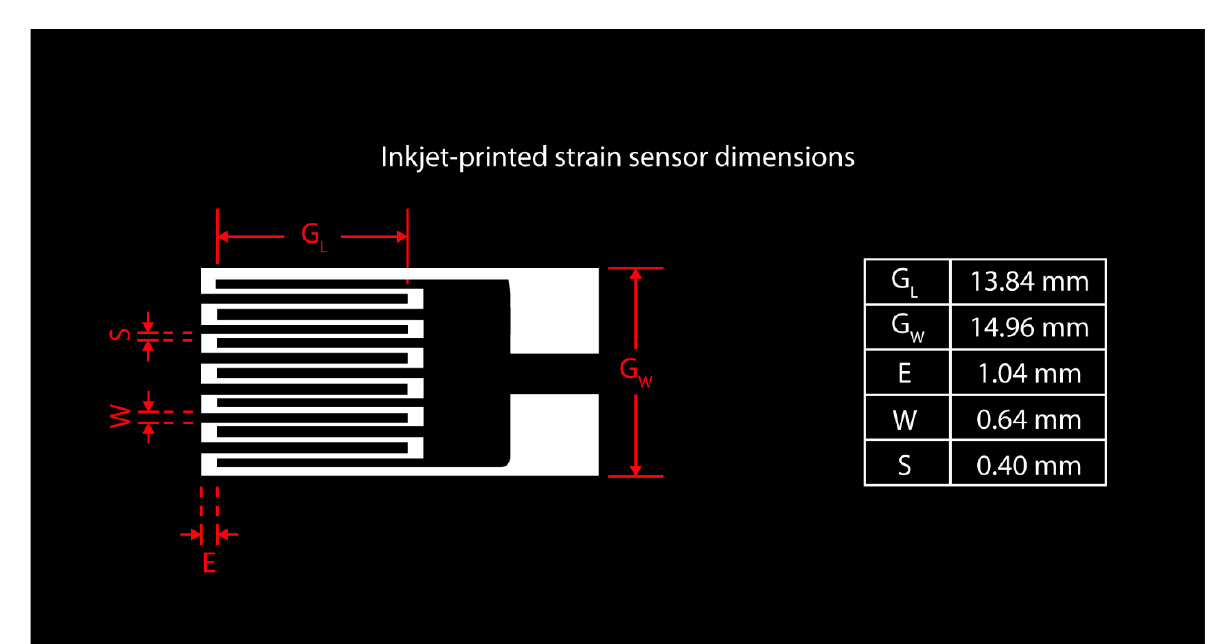
Figure A5. Strain sensor dimensions.